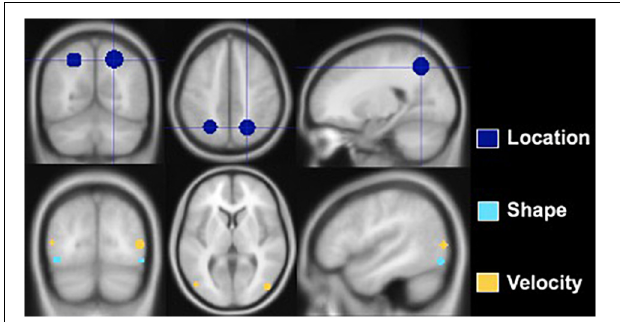
FIGURE 3 | Regions of interest constructed for Location, Shape, and Velocity. The Location ROI is situated in the posterior parietal lobe, the Shape ROI in the lateral occipital, and the Velocity ROI at the junction of the occipital, temporal, and parietal lobes.